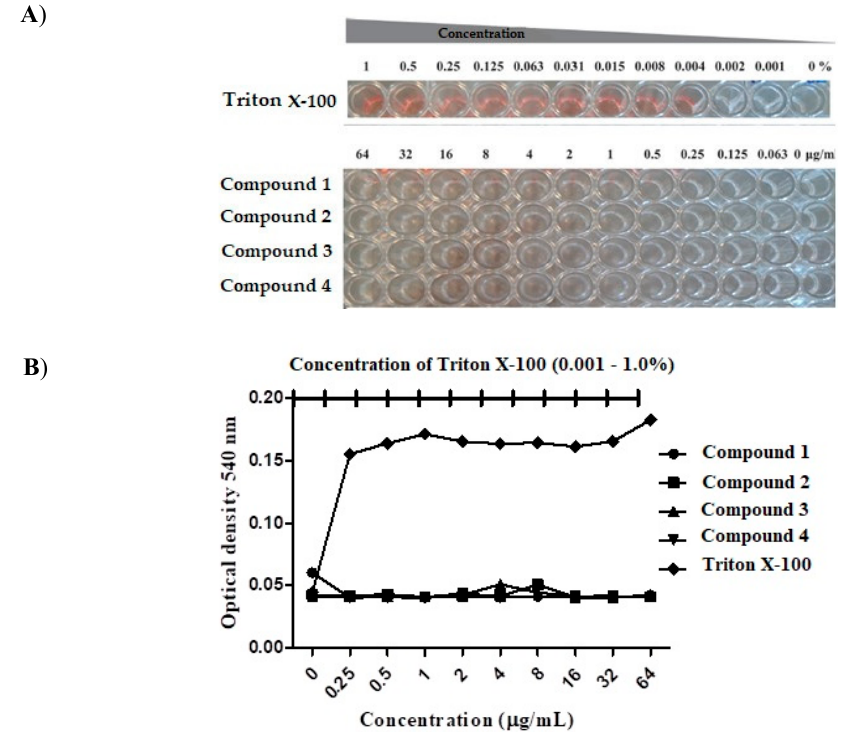
Figure 2. Hemolytic activity of thiazolylhydrazone. Human erythrocytes were treated with serial dilutions of the thiazolylhydrazone compounds 1 , 2 , 3 and 4 (0.25–64 µ g/mL) or Triton X-100 (0.001–1%). ( A ) Visual inspection of the hemolytic activity demonstrated that the thiazolylhydrazone compounds ( 1 – 4 ) did not lyse human erythrocytes. The wells in red color indicated that the Triton X-100 lysed the human erythrocytes and acted as a positive control. ( B ) Hemolysis measured spectrophotometrically at 540 nm.